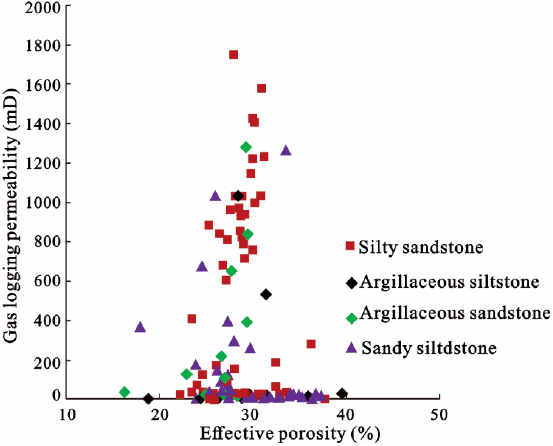
Figure 2. Porosity – permeability relationship of P Formation in Kalamkas Oilfield